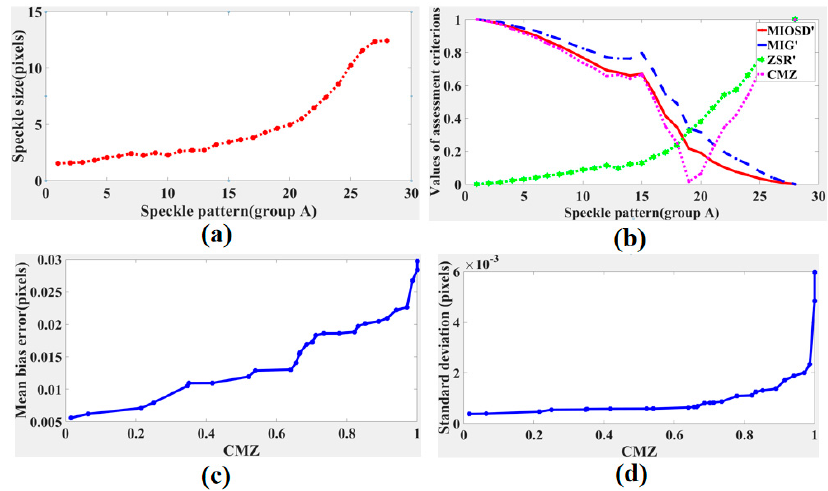
Figure 6. Results of speckle patterns in group A: ( a ) speckle size curve, ( b ) assessment criteria, ( c ) mean bias errors with different CMZ values, and ( d ) standard deviations with different CMZ values.